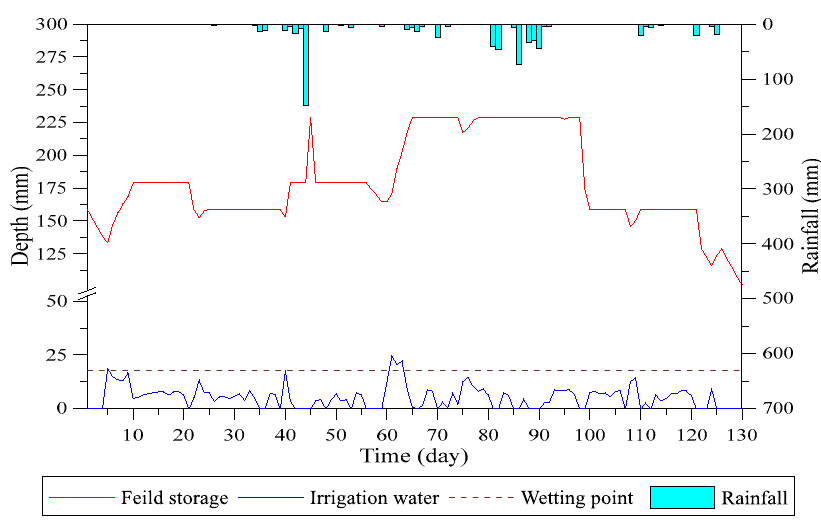
Figure 18. Simulation of block 4 under 30% reduction of planned irrigation water during first crop season.